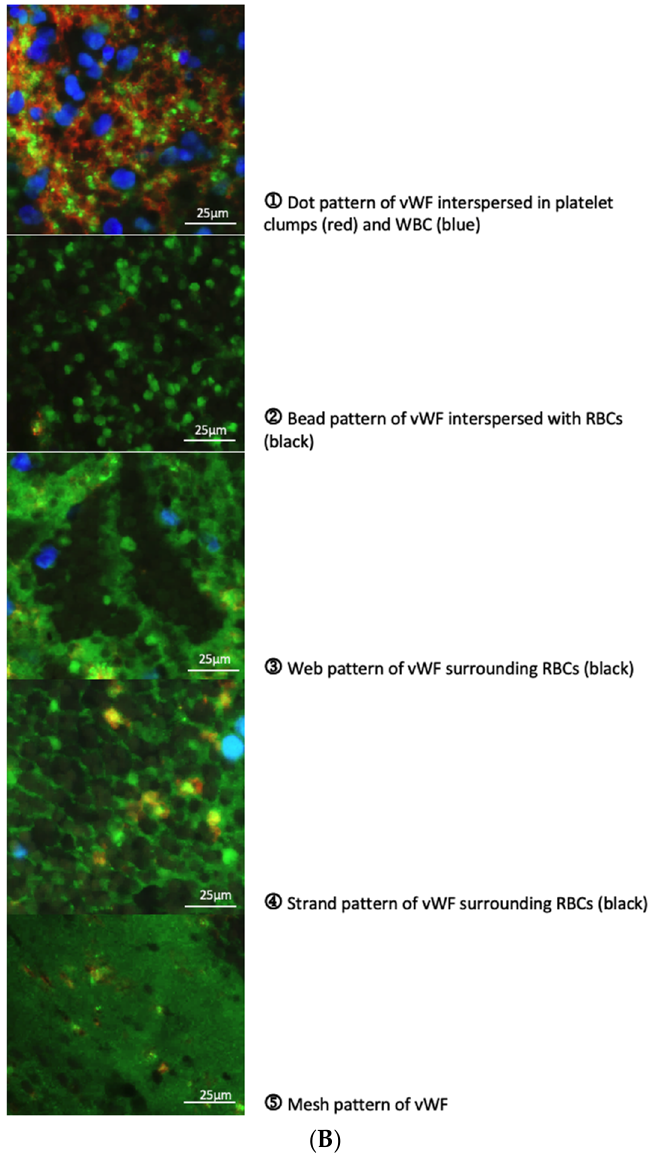
Figure 7. Enlarged image of the LA thrombus from Cat CHF 8. The clump of WBCs and platelets denoted by a thick white arrow in ( A ) is the same area of the thrombus from CAT CHF 8 shown in the middle left hand image of Figure 6. Different patterns of vWF staining and the variety of blood cell types in different areas of the thrombus are shown in ( B ) 1–5: 1—dots interspersed in clumps of platelets; 2—beads interspersed within RBC; 3—web surrounding RBC; 4—strands surrounding RBC; 5—mesh with minimal platelets, RBC, or WBC.